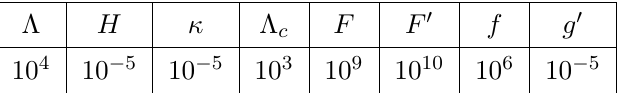
Table 1 . The example set of parameters satisfying the condition of particle production mechanism after the inflation. Notice that we represent the parameters in